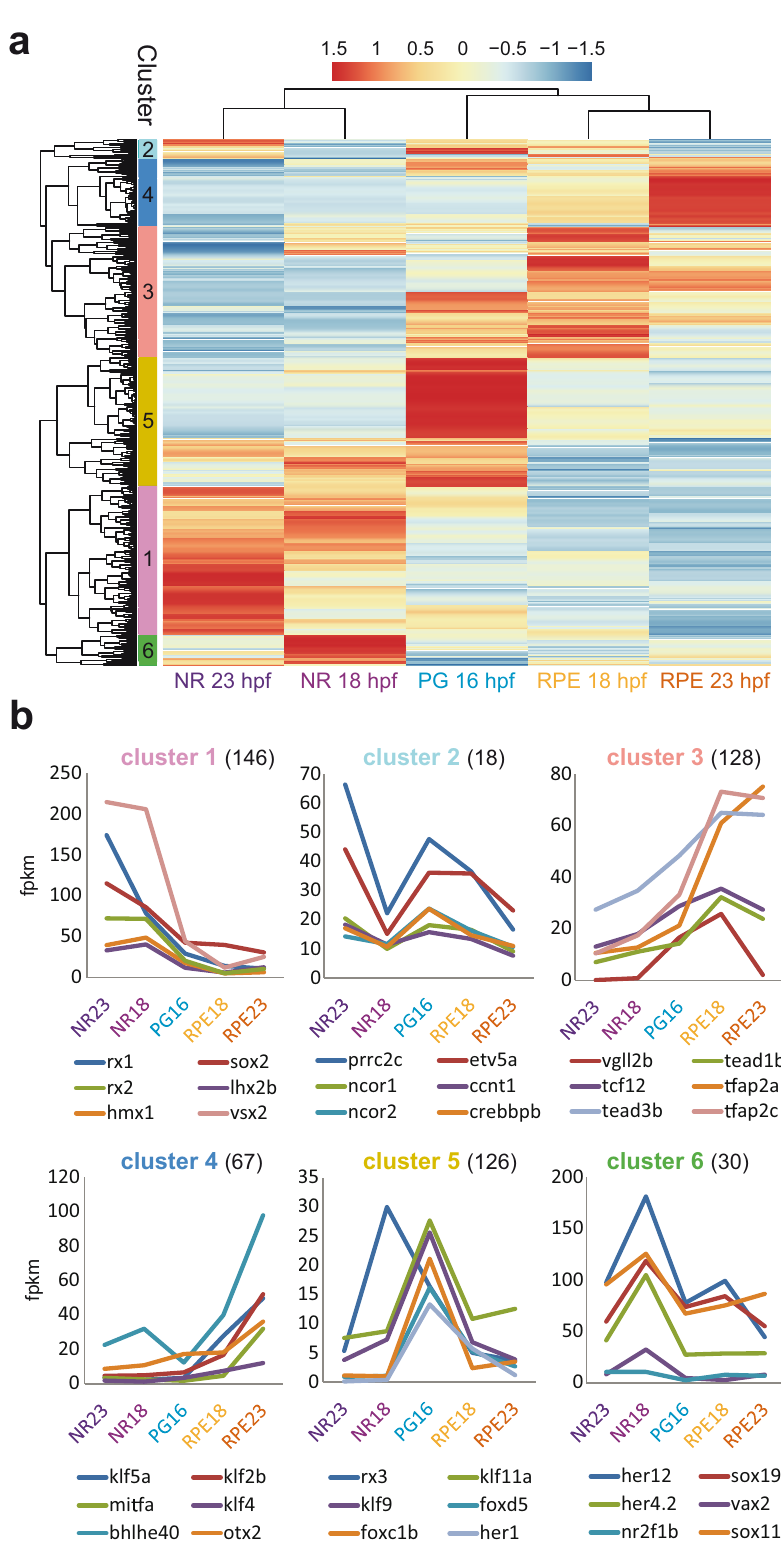
Fig. 3 Hierarchical clustering of TFs gene expression variations during optic cup development. a Hierarchical clustering output shows TFs expression trends in the distinct domains and stages. Gene expression values, normalized by row, are indicated with a red to blue graded color. Note that most clusters comprise a particular domain and developmental stage. b Relative transcript level changes for signi fi cant TFs ( n ) within each